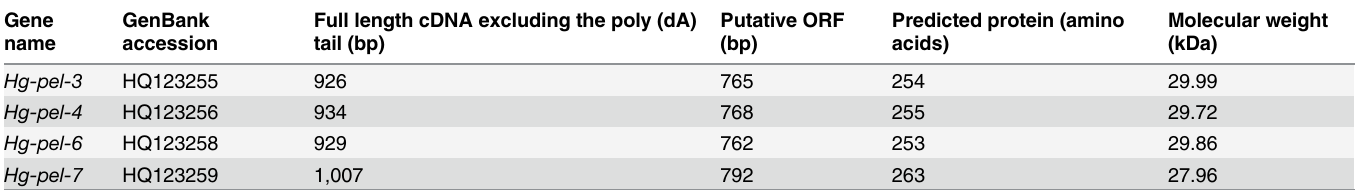
Table 1. Sequence information of the four novel pectate